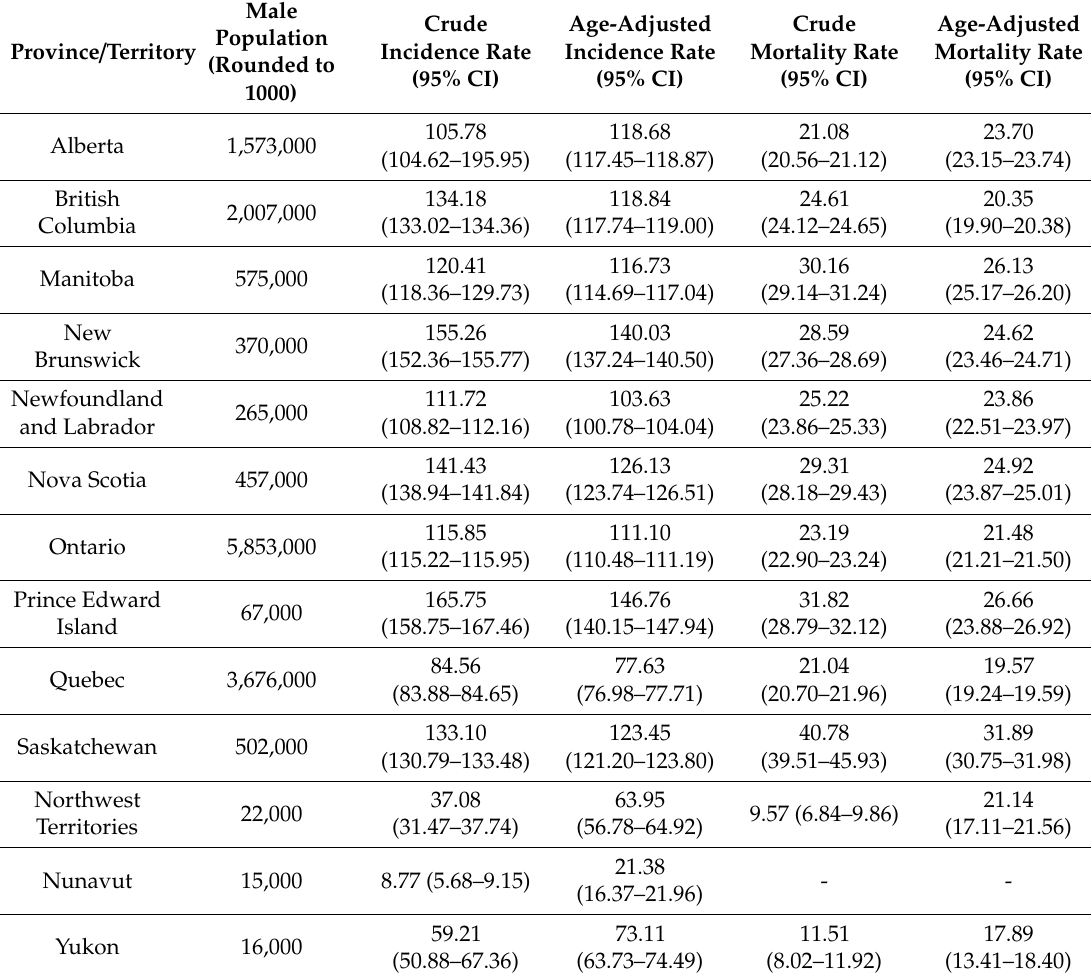
Table 2. Crude and age-adjusted incidence and mortality rates and corresponding confidence intervals for prostate cancer by province in Canada between 1992 and 2010. Incidence and mortality rates are expressed per 100,000 men per year. The 95% confidence intervals were calculated based on Poisson distributions and were adjusted for rare e ff